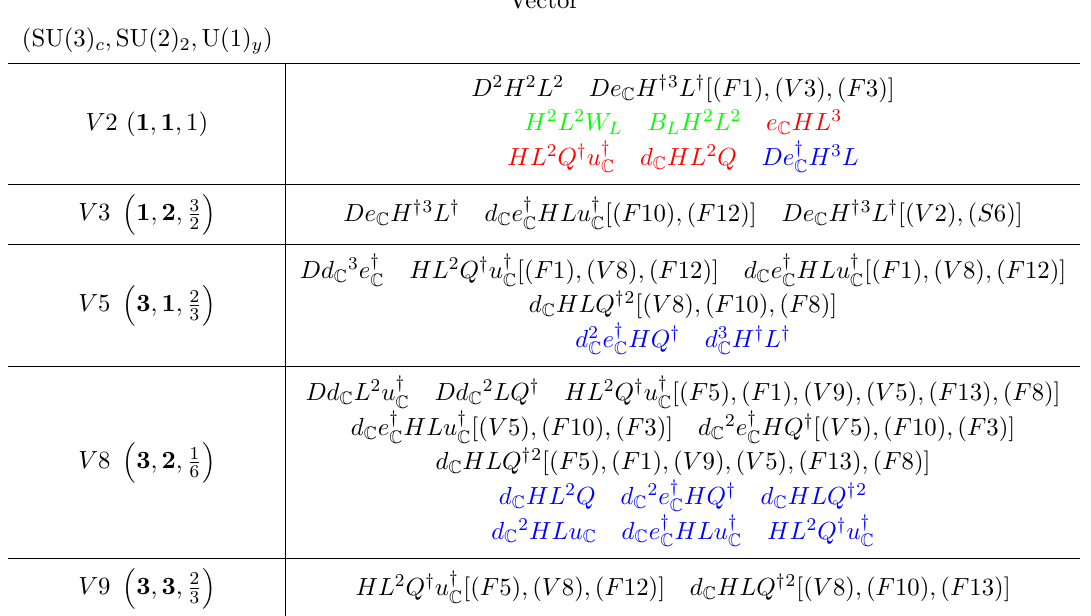
Table 20 . Vector resonances which could generate the dim-7 operators. The name of the resonances is organized by the gauge quantum number. The resonance appeared in the squared bracket of the operator indicate that both resonances are needed to generate such operator.